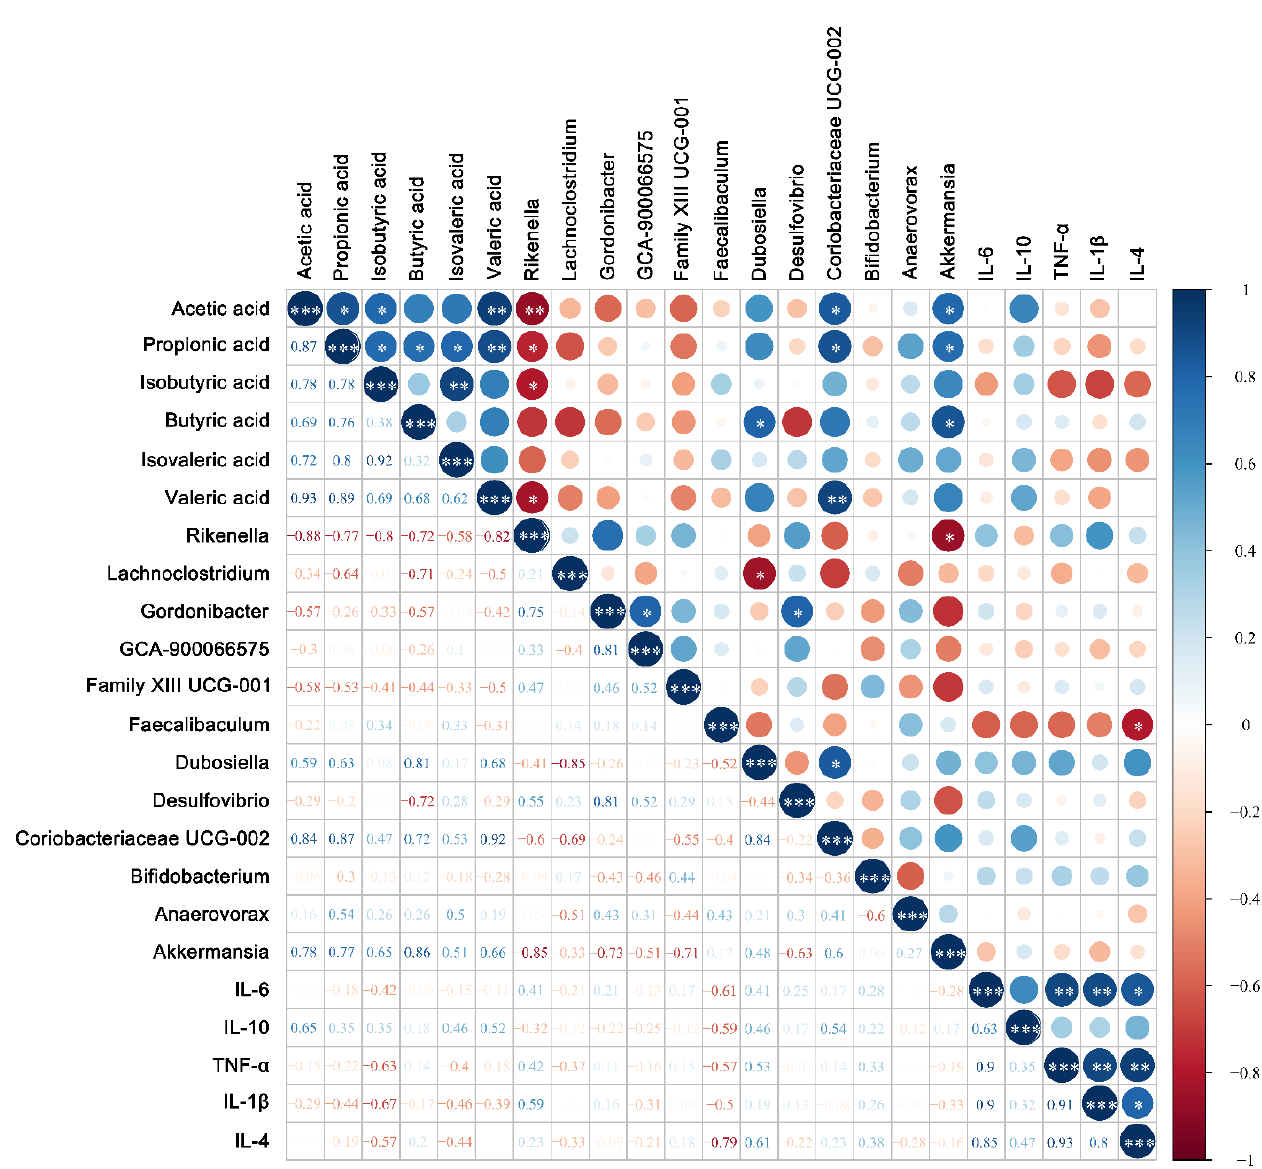
Figure 10. Correlation analysis of horizontal composition with short-chain fatty acids and cytokines of the fecal flora of mice in the Bifidobacterium group. * p < 0.05; ** p < 0.01; *** p < 0.001. The size of the circle represents the strength of the correlation, the negative value represents the negative correlation, and the positive value represents the positive correlation.